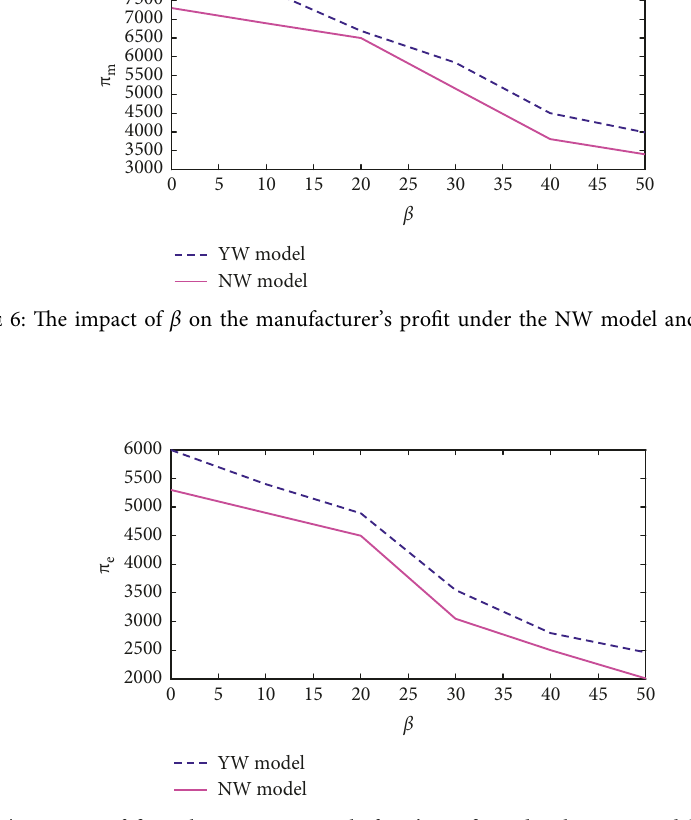
Figure 7: The impact of β on the e-commerce platform’s profit under the NW model and YW